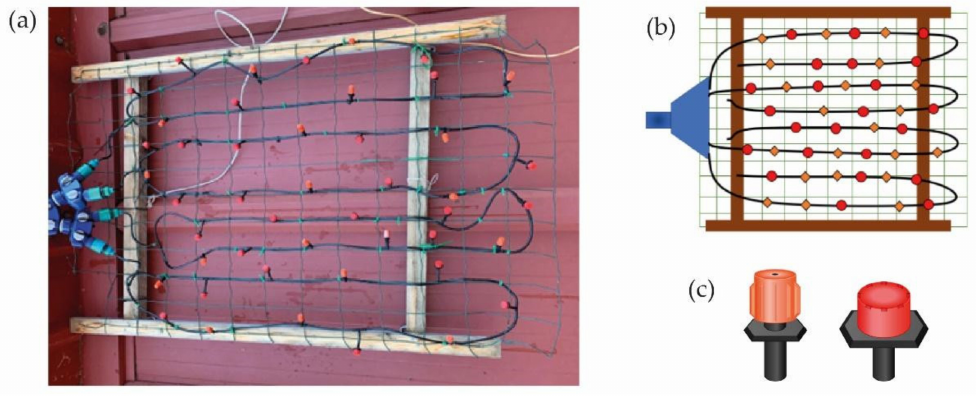
Figure 2. Figure showing the first wooden hanging structure: ( a ) photo of the wooden structure, ( b ) dripper placement scheme, and ( c ) types of